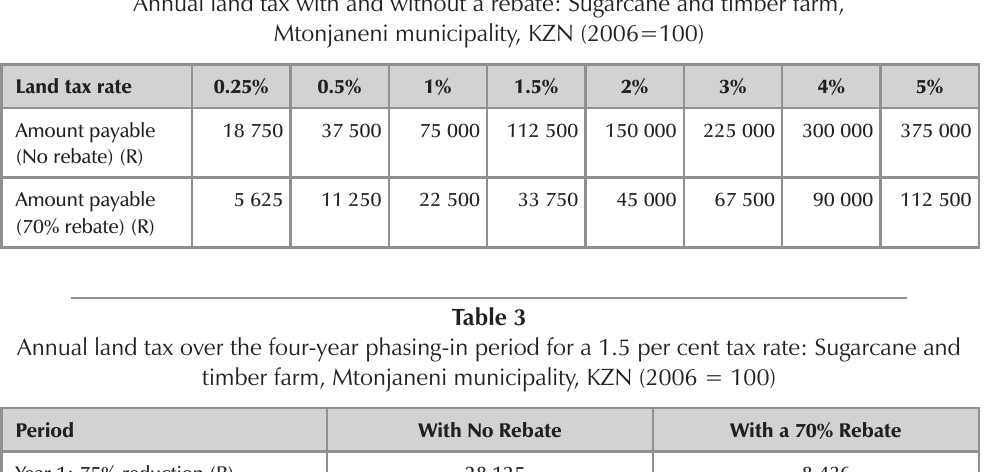
Annual land tax with and without a rebate: Sugarcane and timber farm,